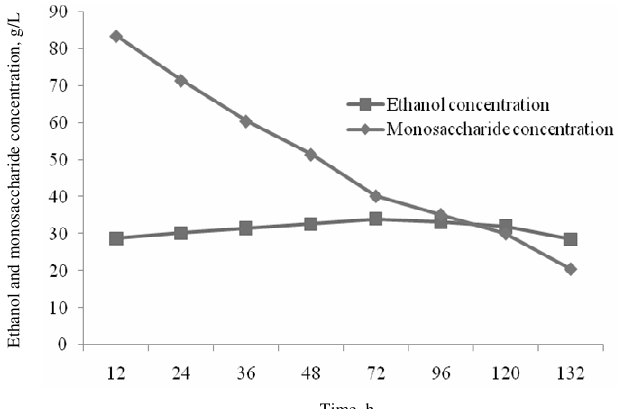
Figure 3. Fermentation of PFR hydrolysate for ethanol production at 50 ° C and 72 minutes hydrolysis